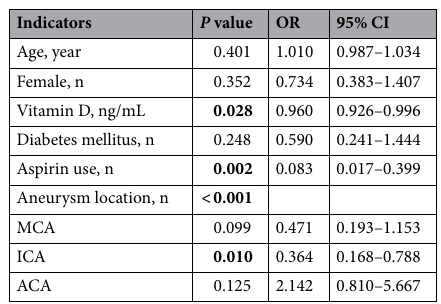
Table 2. Binary logistic regression between UIAs and RIAs. Posterior circulation (reference). Bold: p <